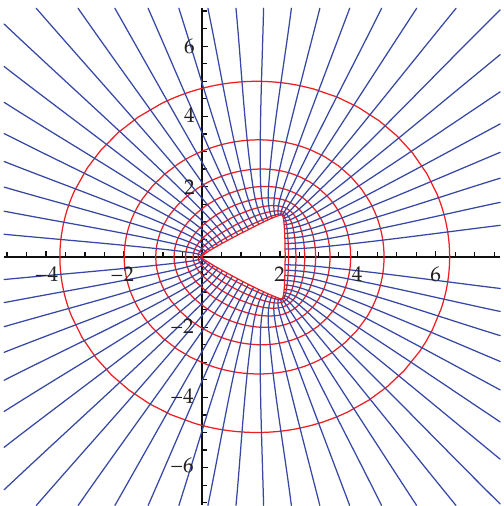
Figure 13: Exterior of the Koch snowflake, Step 1.